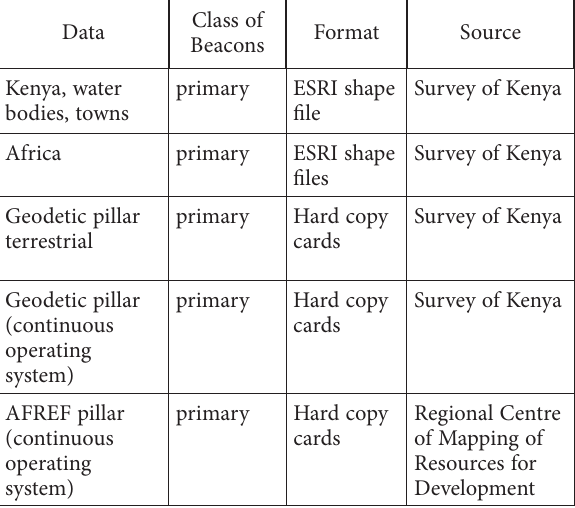
Table 1. Data type format and